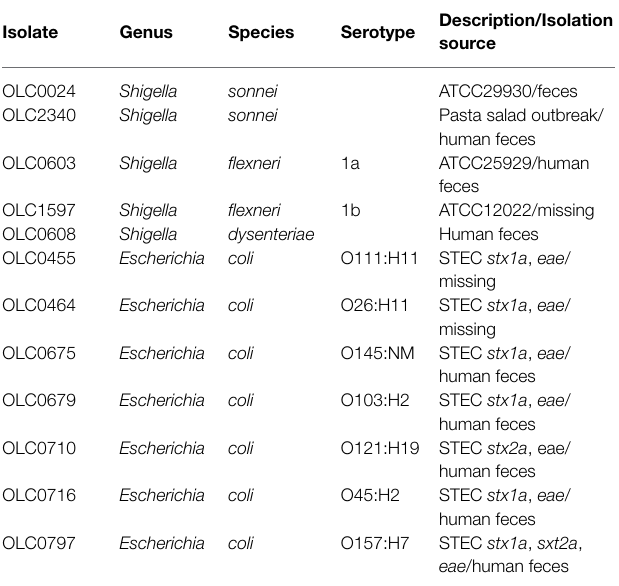
TABLE 1 | STEC and Shigella strains used as indicator